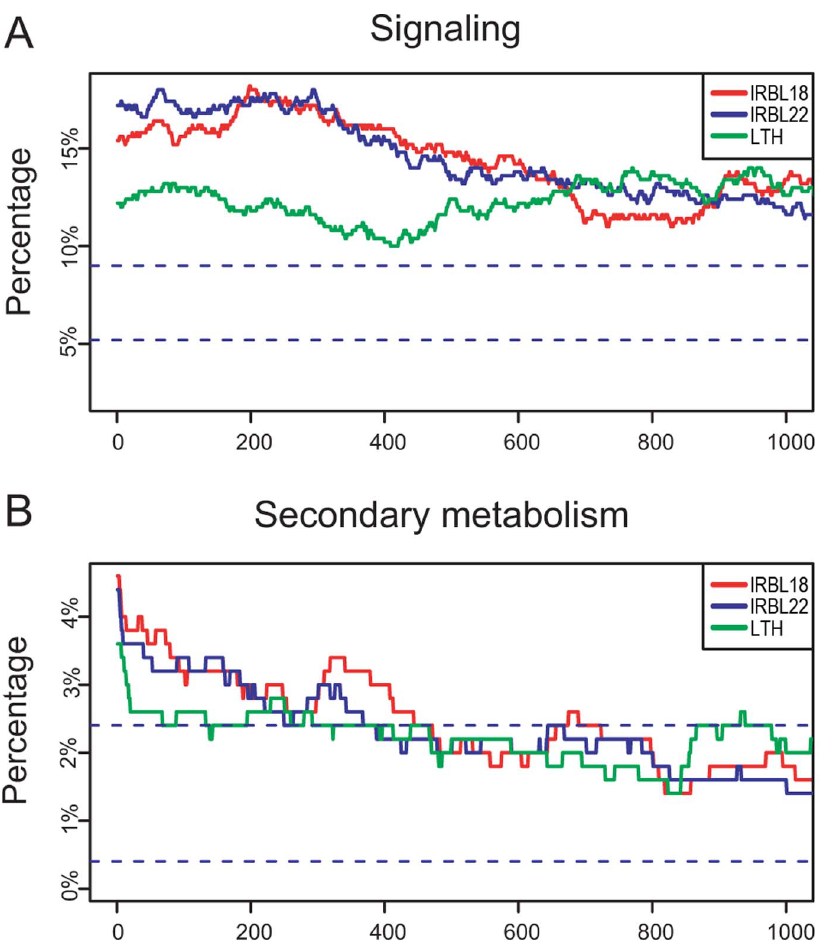
Figure 6. The sliding window analysis of genes involved in signaling (A) and secondary metabolism (B). The solid lines represent the percentages of certain functional category in a 500-gene window in IRBL18 (red), IRBL22 (blue) and LTH (green). The blue dotted lines represent the 95% confidence levels.